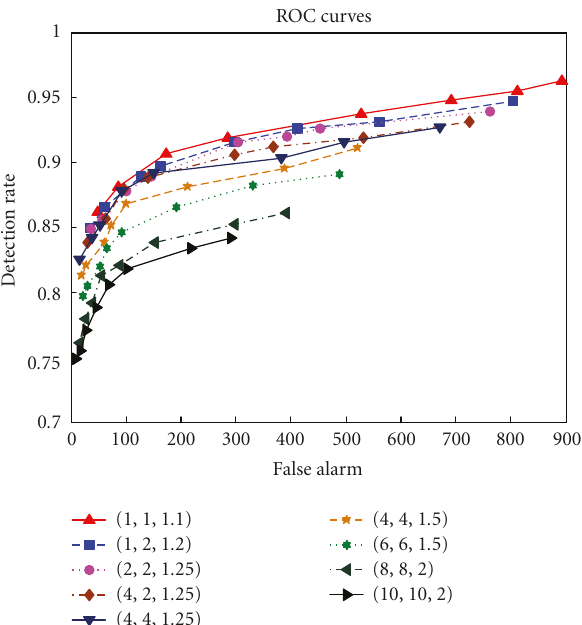
Figure 18: Variation of detection accuracy for 320 × 240 images while changing S x , S y and r .